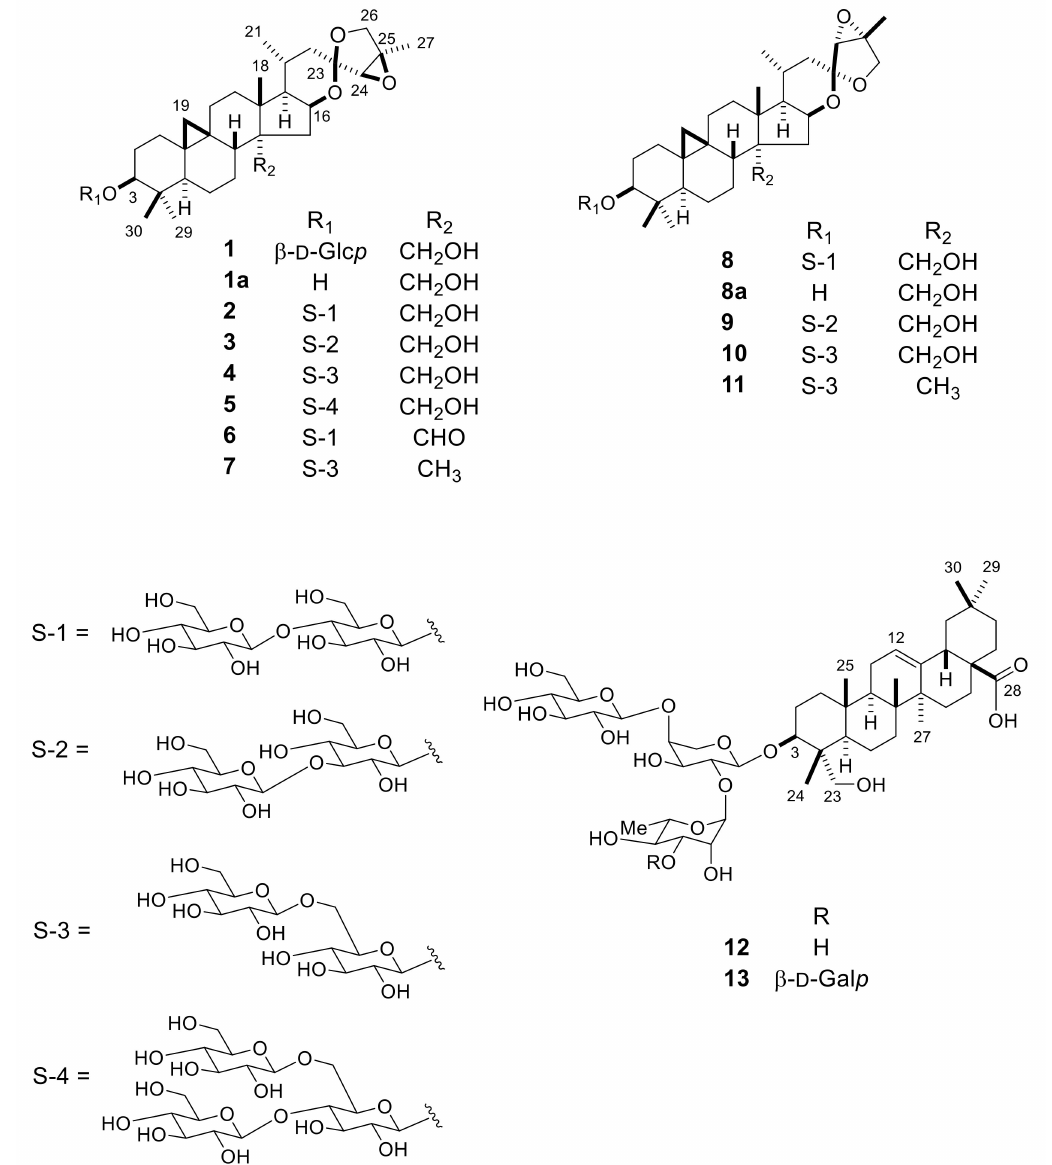
Figure 1. Structures of 1 , 1a , 2 – 8 , 8a , and 9 –